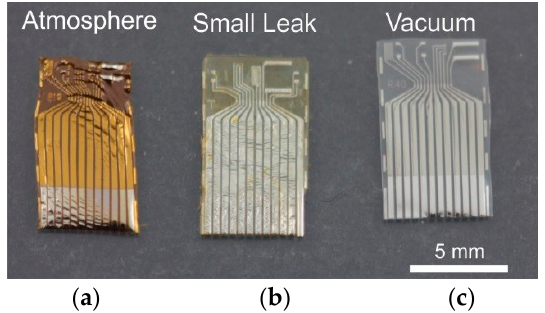
Figure 5. Comparison of thermal annealed devices in the presence of oxygen ( a , b ) and under intact vacuum ( c ). Devices were heated at 200 °C for 48 h.